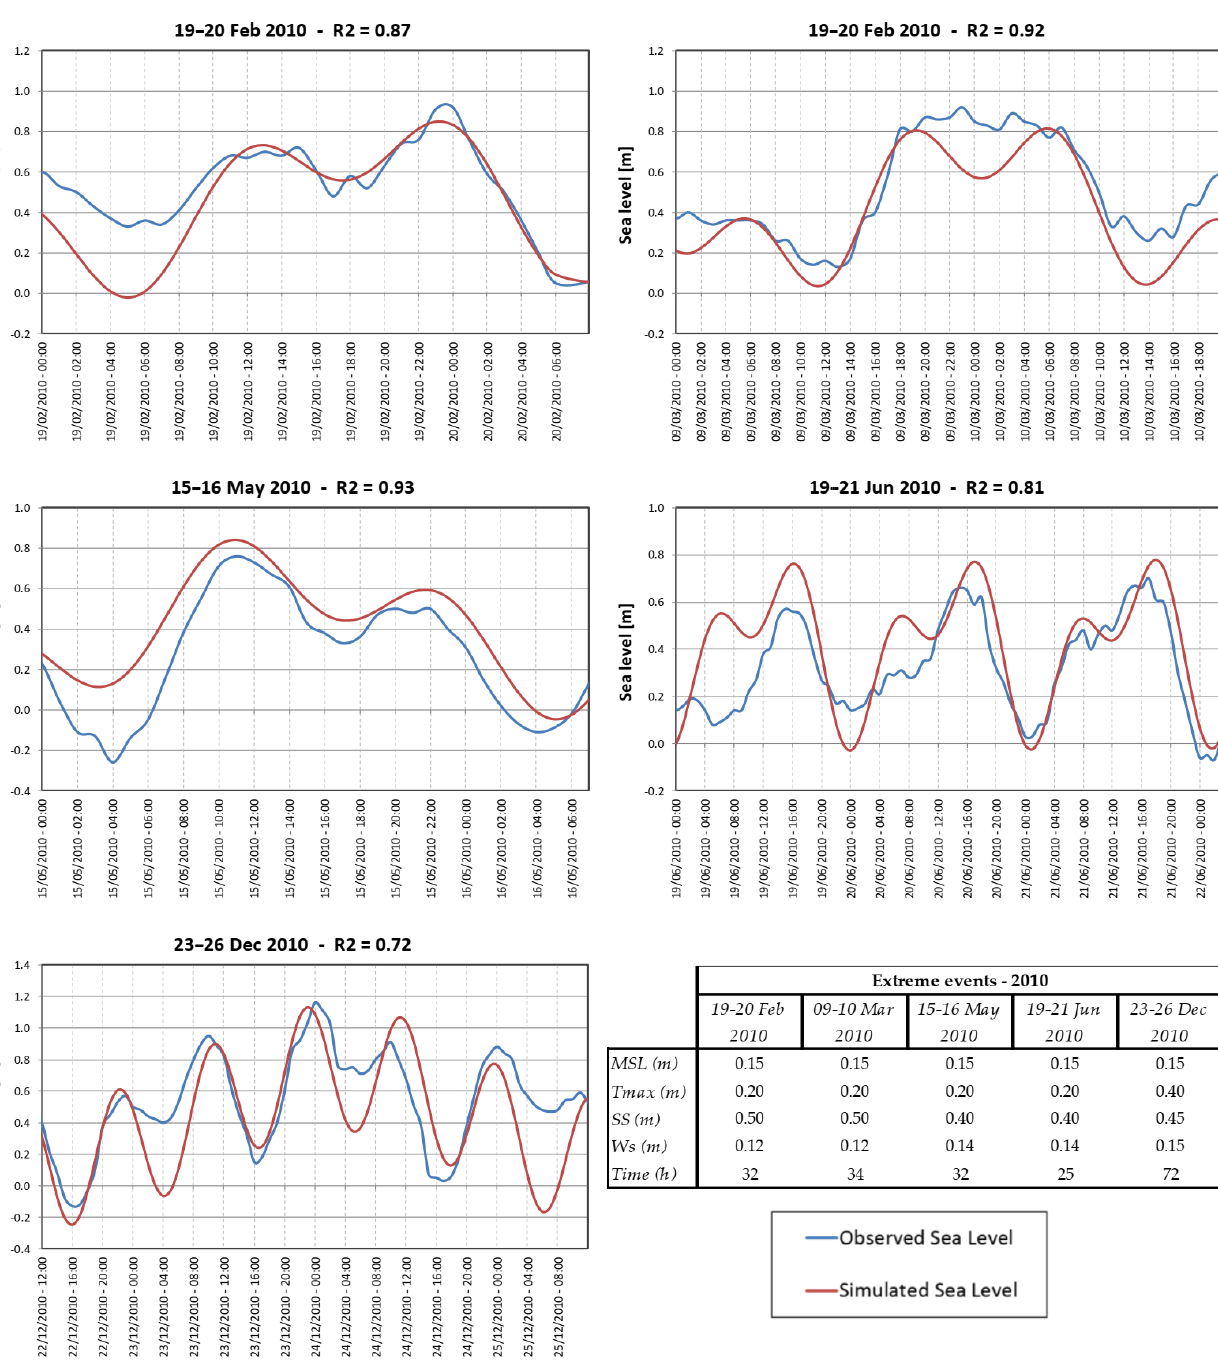
Nat. Hazards Earth Syst. Sci., 22, 265–286, 2022